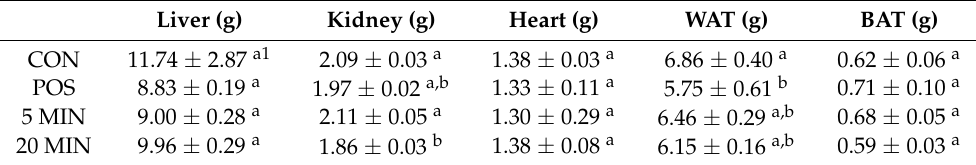
Table 5. Changes in rat organ weights.